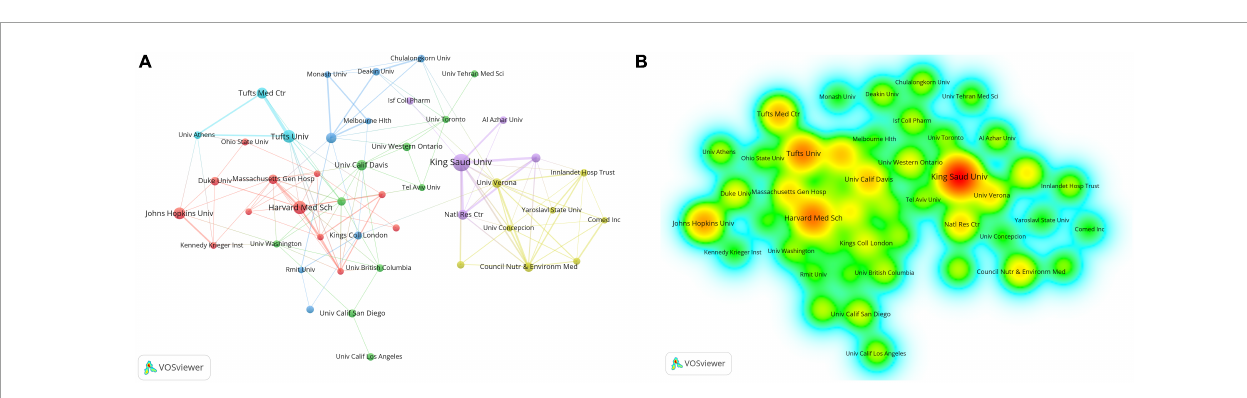
FIGURE4 (A) The cooperation network visualization map of institutions based on VOSviewer: The thickness of the line represents the strength of cooperation between institutions. (B) The density visualization map of institutions based on VOSviewer: The density of color indicates how many publications for